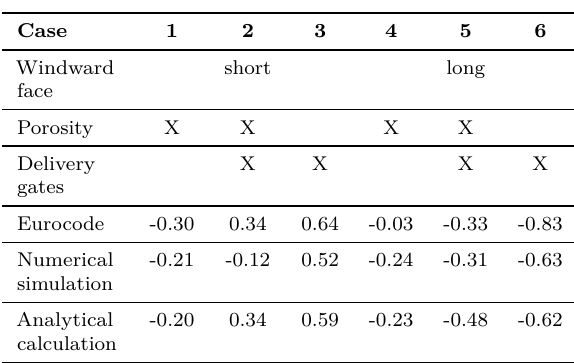
Table 3. Comparison of the internal pressure coeffi- cients c pi for the six considered load cases.